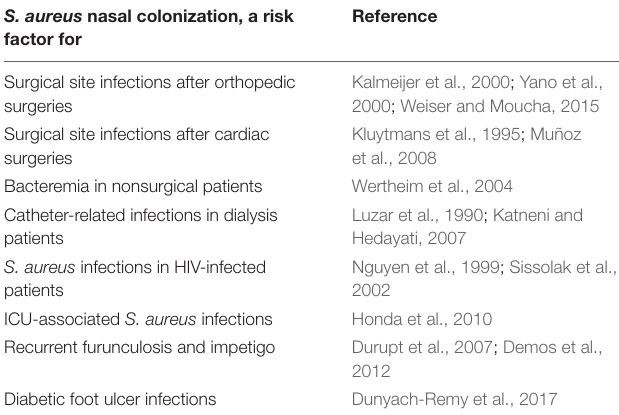
TABLE 3 | S. aureus nasal colonization, a risk factor for